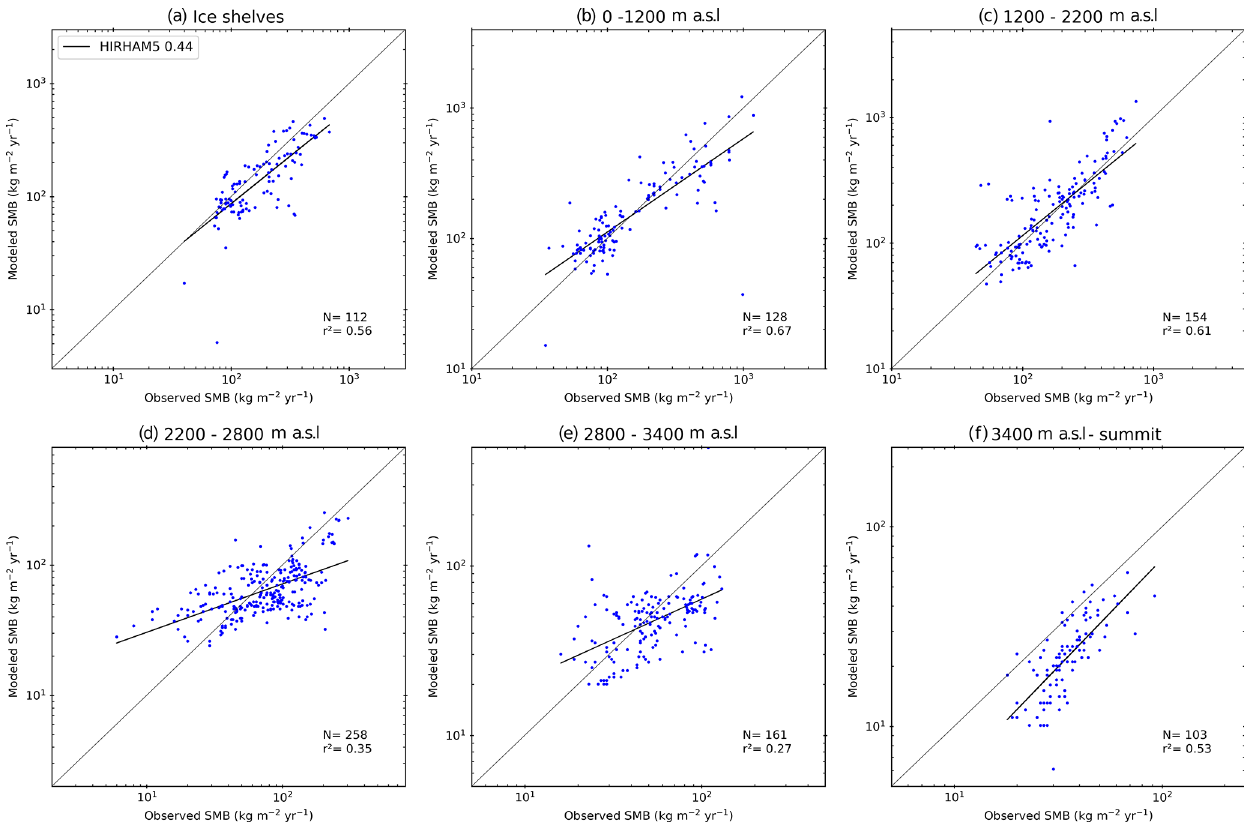
Figure A5. Comparison between HIRHAM5 0.44 ◦ and observed SMB (units: kgm − 2 yr − 1 ) over the ice shelves (a) and by elevation classes (b–f) . Due to the use of logarithmic axes, only positive values for the observed and modelled SMB from all the RCMs in this study are used (number for each bin N ). Finally, the regression coefficient of each regression line is also shown ( r 2